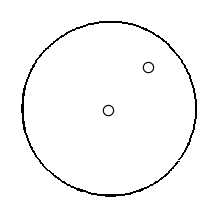
Figure 1 . The (cid:12)gure on the left shows a Feynman diagram obtained by joining the open string states from a pair of open-closed interaction vertices by an open string propagator. The thick lines labelled by the symbol C denote closed strings and the thin line labelled by the symbol O denotes open string. A (cid:2) denote an interaction vertex. This is the convention we shall follow in all the subsequent (cid:12)gures. The (cid:12)gure on the right gives the representation of the Feynman diagram as a disk amplitude, with the closed string vertex operators, denoted by (cid:14) , inserted at 0 and z 1 (1 (cid:0) u ) = (1 + u